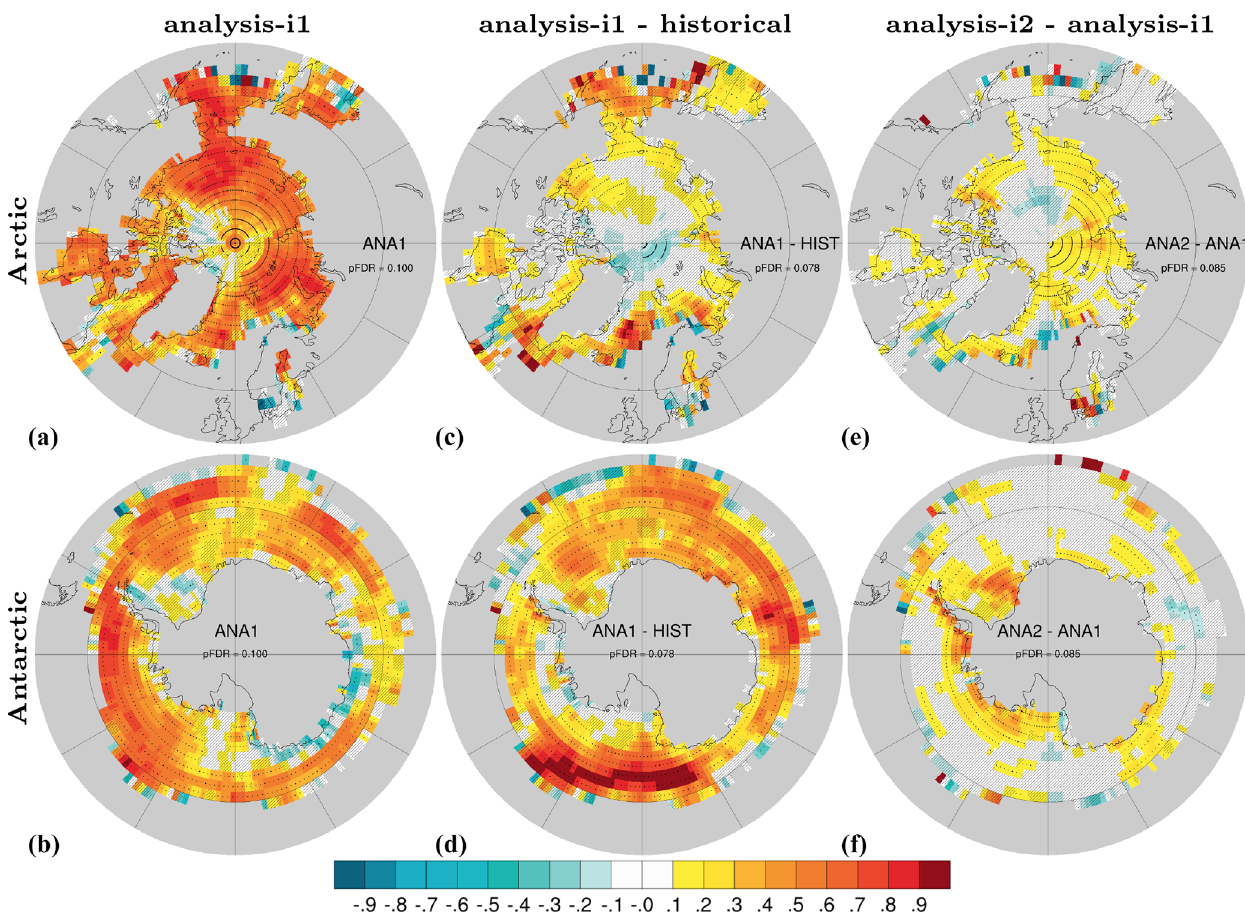
Figure 9. ACC for annual sea ice concentration in Arctic (a) and Antarctic (b) for assim-i1 . (cid:49) ACC for assim-i1 – historical (c–d) , assim-i2 – assim-i1 (e–f) . Observations are from HadISST (Rayner et al., 2003) over the period 1950–2018. The data are interpolated to a regular 2 ◦ × 2 ◦ grid. Hatched areas are not locally significant; dotted areas are field significant.